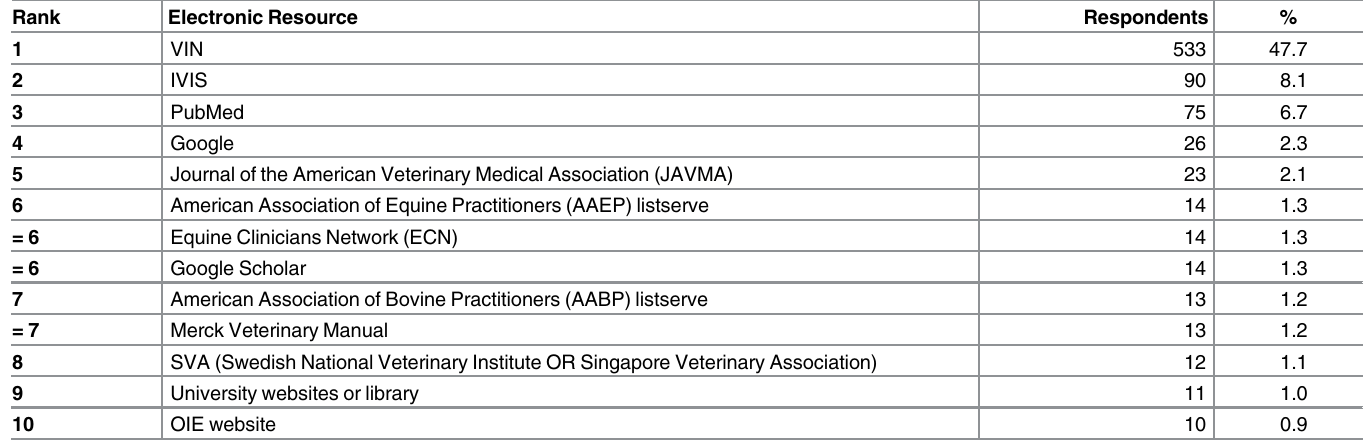
Table 9. Top 10 Electronic resources nominated by respondents as most useful (n = 1117).